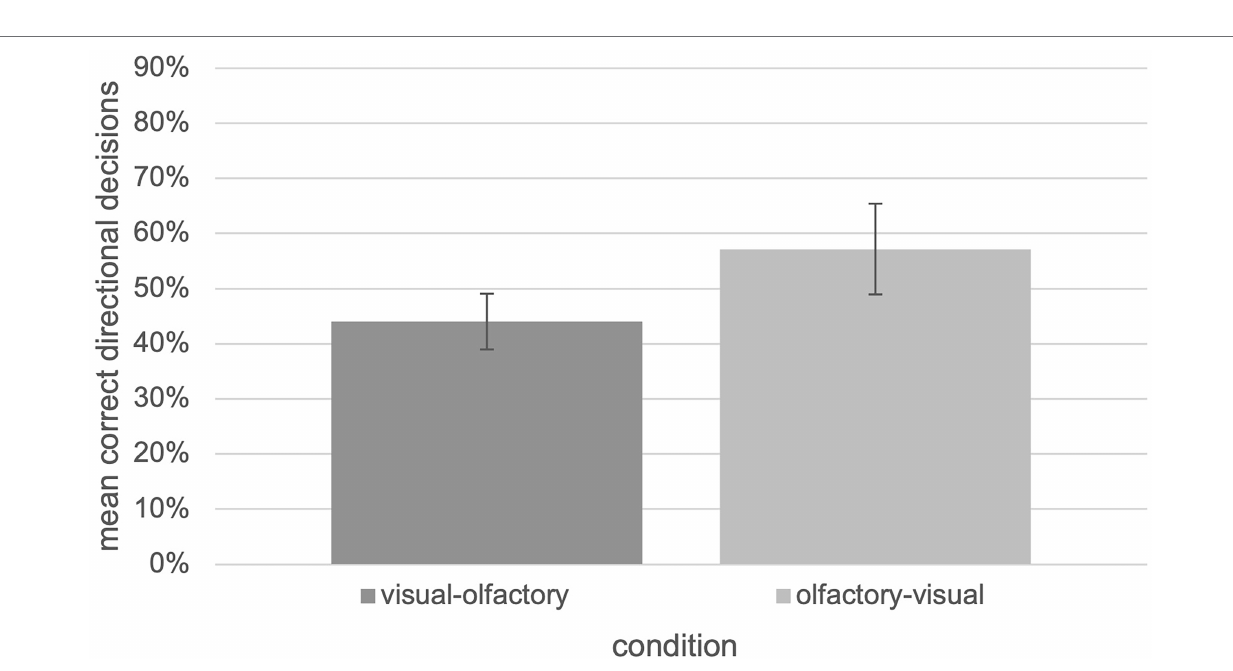
FIGURE 6 | Relative number of correct decisions with respect to the “visual-olfactory” and “olfactory-visual” switch condition of the tested experiment ( N = 30, error bars =